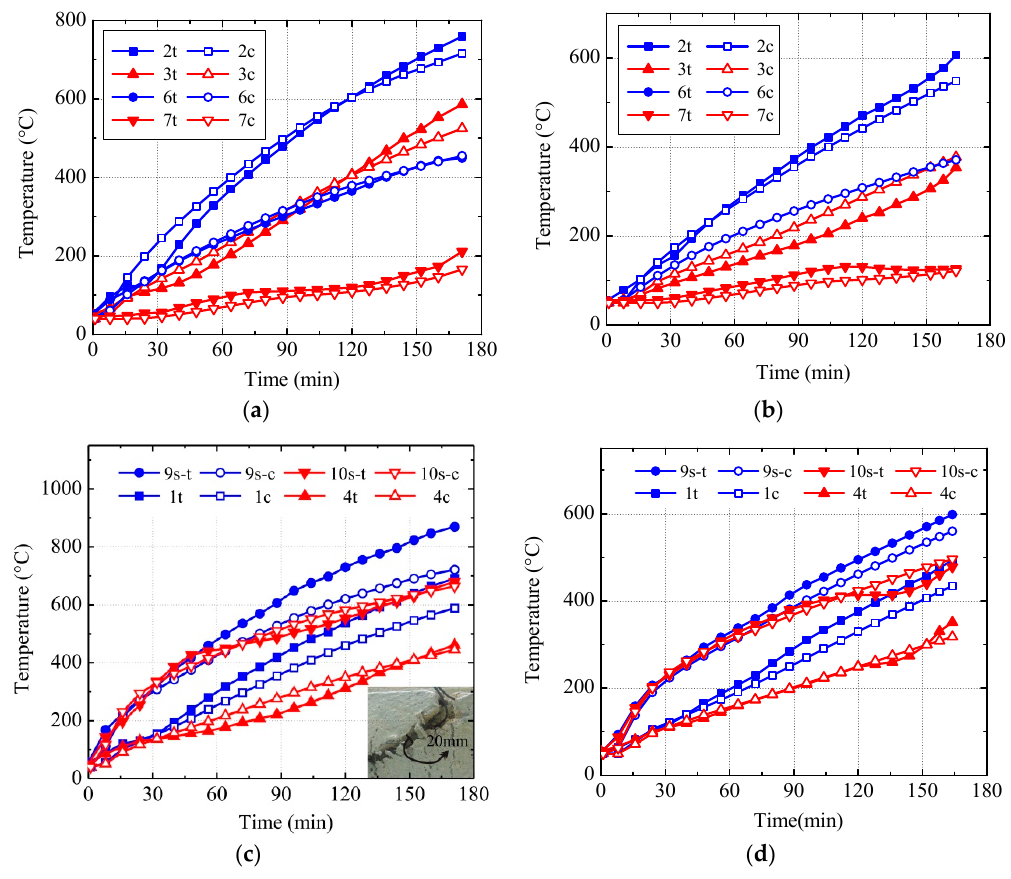
Figure 23. Calculated and measured temperature-time curves: ( a ) Specimen B4, ( b ) Specimen B5, ( c ) Specimen B4, and ( d ) Specimen B5.